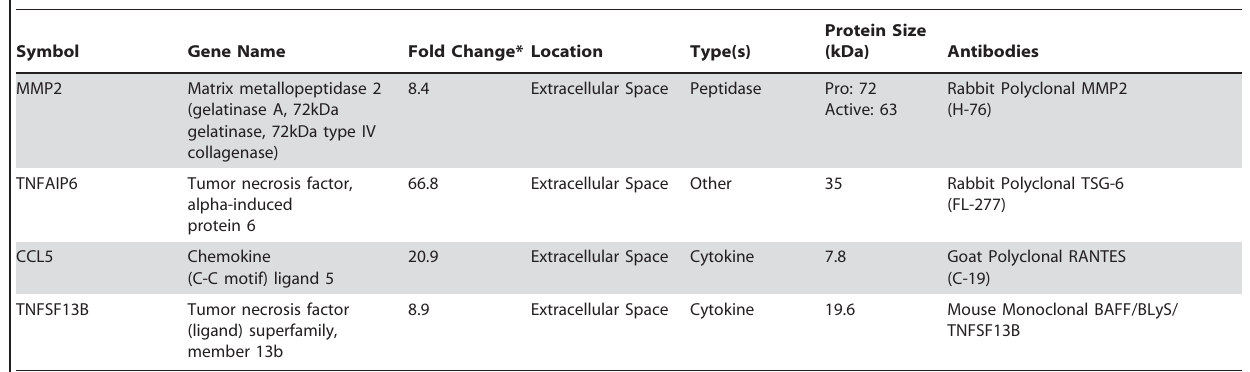
Table 5. Summary of validated